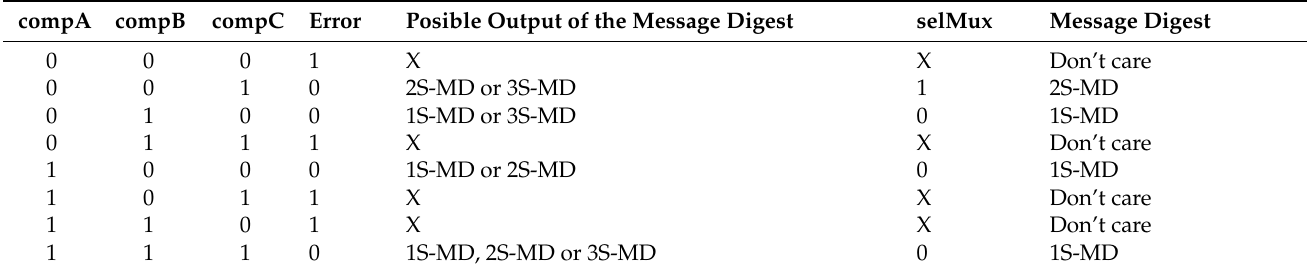
Table 2. Combinations of inputs for Error and Message Digest